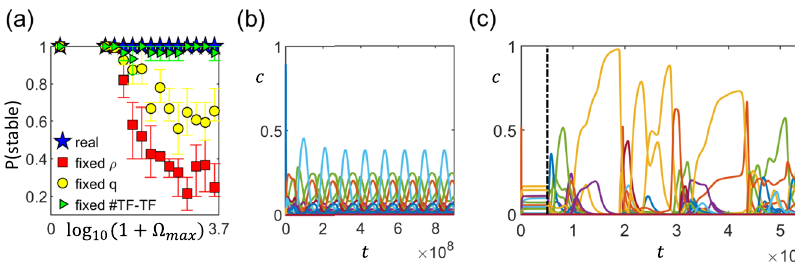
Fig. 4 Comparing the E. coli transcriptional regulatory network with random networks of the same density. a The actual E. coli network does not become unstable even when the maximum regulation strength Ω max is increased (blue stars). In contrast, as Ω max increases, the probability P(stable) of the system having a stable fi xed point decreases for scrambled networks of the same interaction density ρ = 0.0011, regardless of whether the number of transcription factors (TFs) q = 211 is kept fi xed (yellow circles) or not (red squares). However, scrambling the network while maintaining the same number of TF-other TF, TF-nonTF, and self interactions can signi fi cantly enhance the probability of the system is stable (green triangles). Each of the data points represents an average over 15 sets of 10 regulatory networks, with error bars indicating the interquartile range. [Other parameters: h = 2]. b A typical example of oscillatory dynamics in protein concentrations c when the system no longer has a stable fi xed point. [Parameters: Ω max ¼ 1585, h = 2]. c An example of the system going unstable and exhibiting chaotic behavior when the real network is scrambled at time t = 5 × 10 6 marked by the dashed vertical line. [Parameters: Ω max ¼ 1000, h = 5]. In both ( b ) and ( c ), time t is in units of 1/ k p .